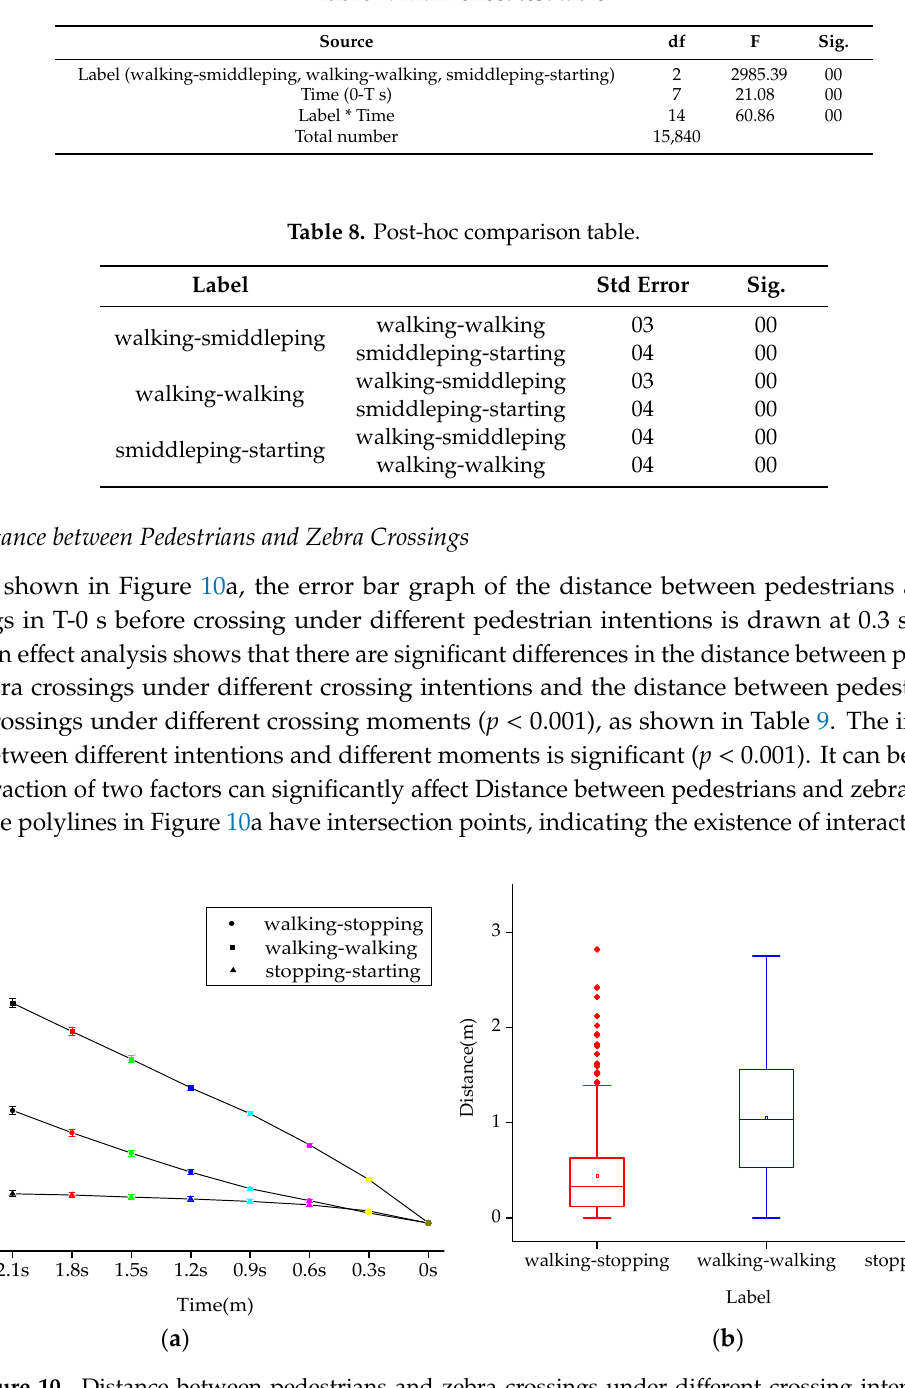
Table 7. Main e ff ect test table.